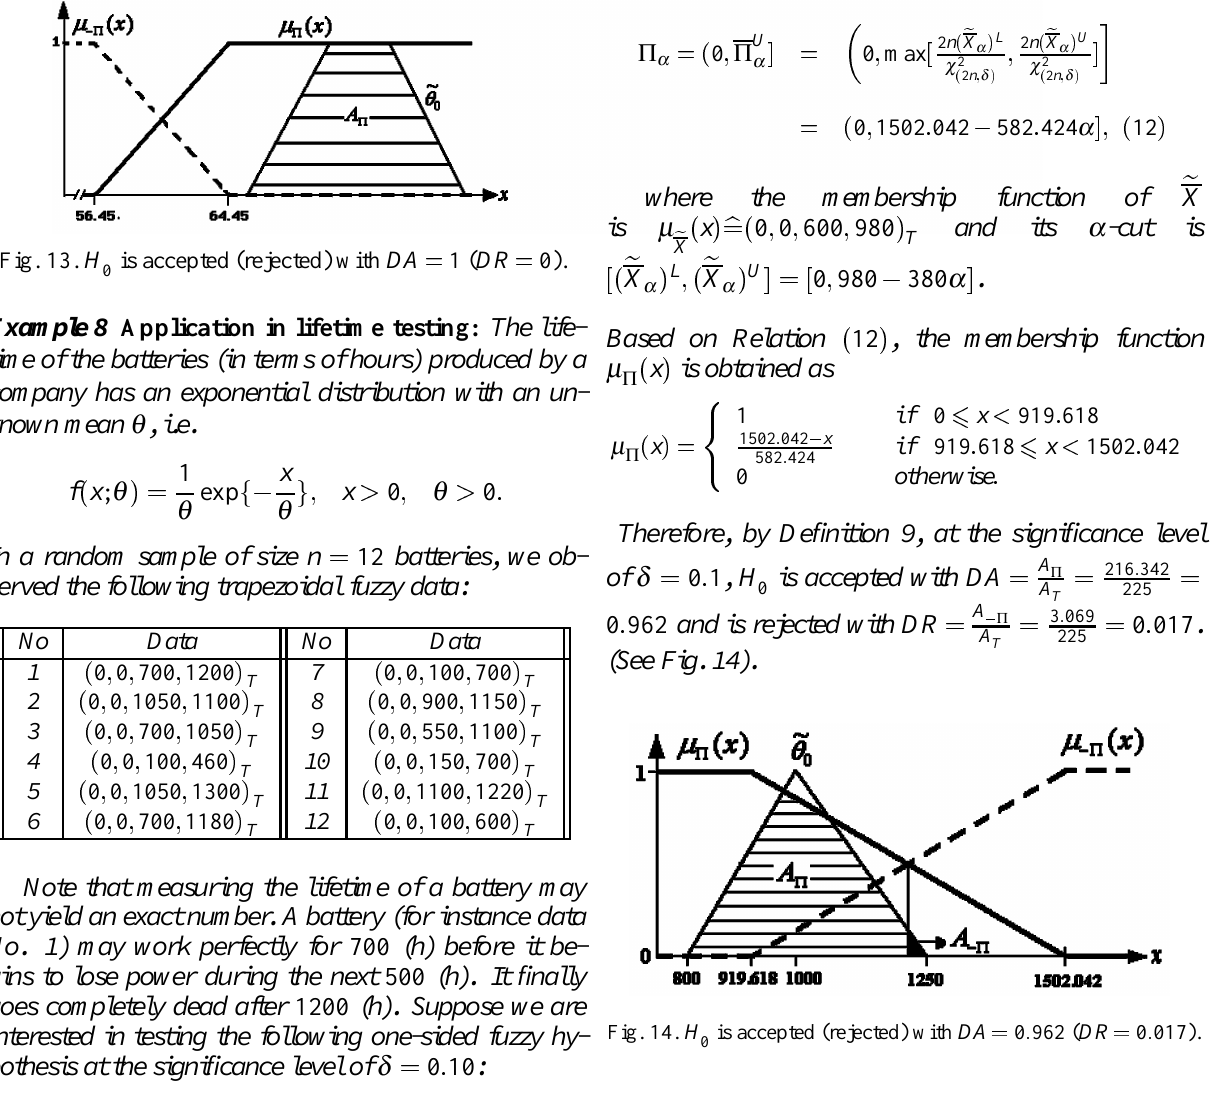
is accepted (rejected) with DA 0